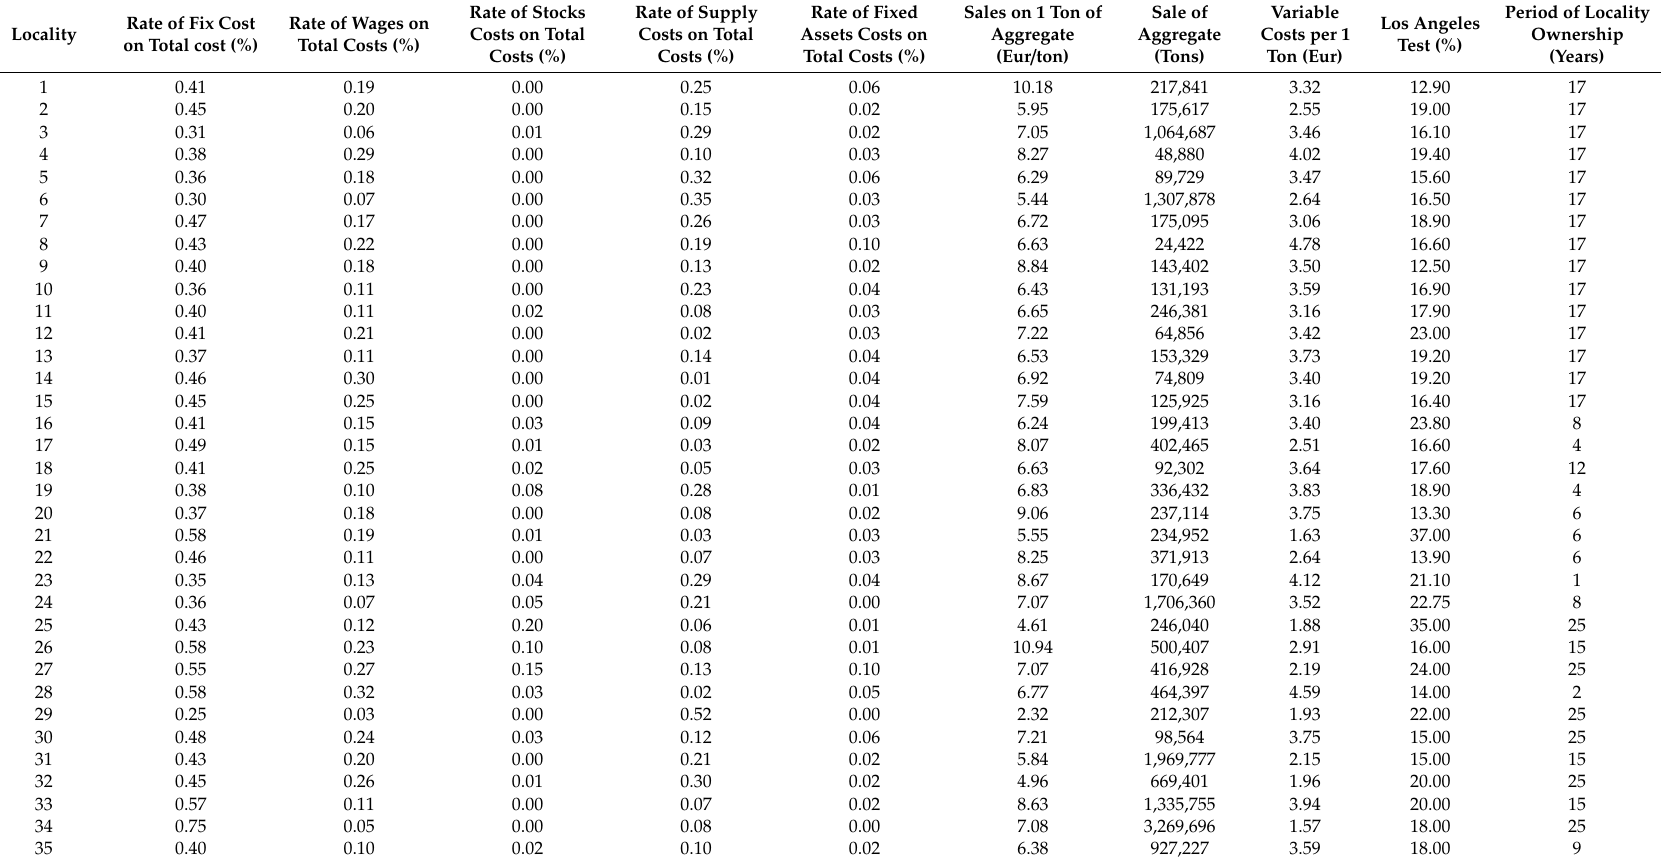
Table 1. Input table of profitable